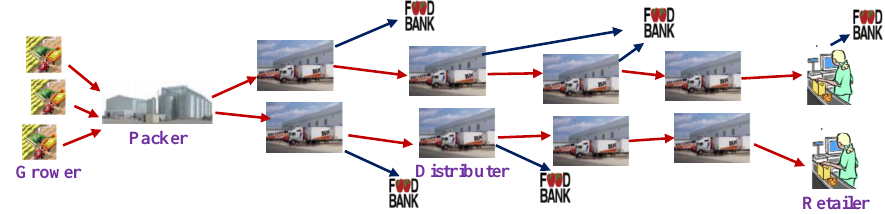
Figure 3. A schematic of our assumed food network